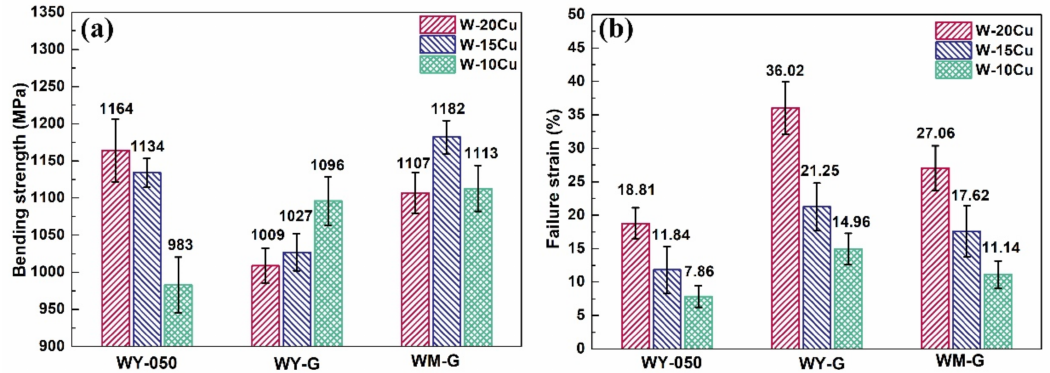
Figure 8. ( a ) Bending strength and ( b ) failure strain of the as-prepared W–Cu